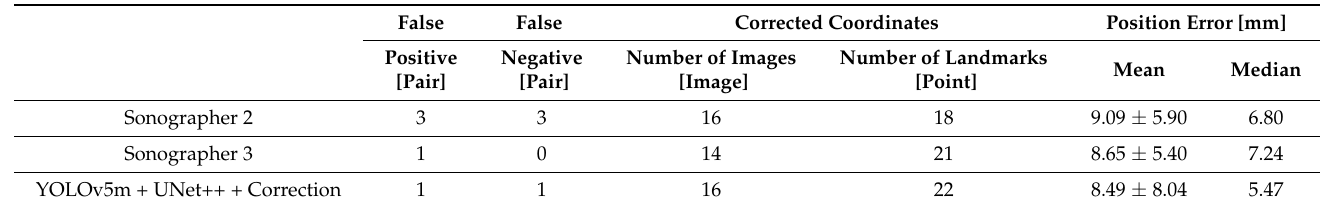
Table 4. Results of post hoc manual evaluation by the most experienced